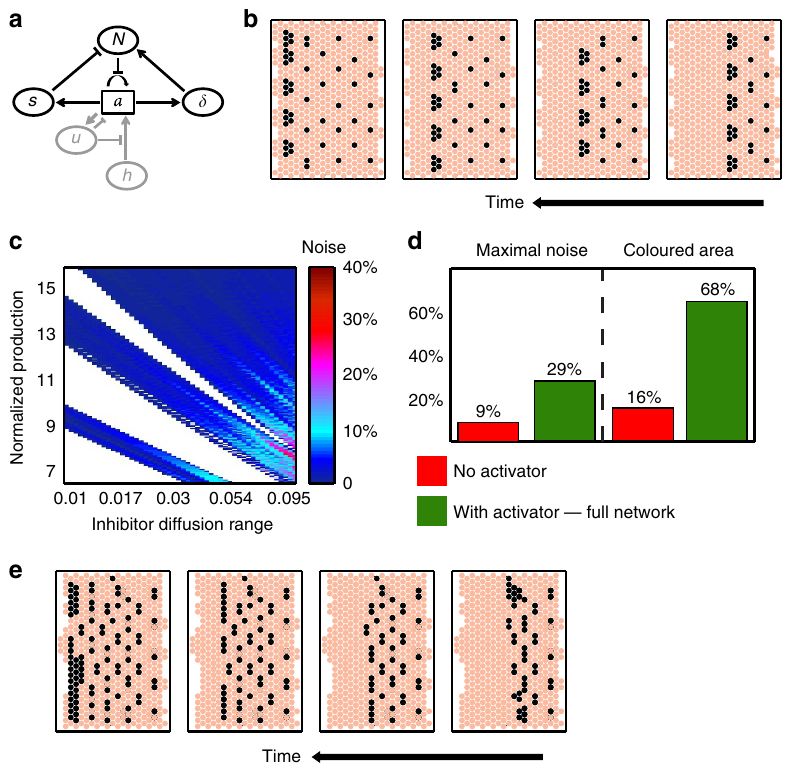
Figure 4 | Simulating sca function as a competitive inhibitor of Notch activity. ( a ) Model scheme of the full network including Notch and Delta. Model equations are given in the Methods and in Supplementary Note 7. ( b ) Introducing the Notch–Delta interactions enables simulating cluster formation together with cluster refinement. Simulations of the same eye disc are shown at different times (indicated by horizontal arrow), capturing the different stages in eye development. ( c , d ) An analysis of the sensitivity of the model to spatial heterogeneity for the extended model. Quantitative comparison of the robustness with or without the addition of the short-range activator is shown in d . Left panel compares the maximal noise that could be added in simulations of the full network shown in c to that in simulations in Fig. 1e (no activator). Right panel compares the area of the coloured regions in these simulations, where patterns could be obtained. Parameters can be found in Supplementary Table 3. ( e ) In sca loss of function mutants, the first distinct phenotype is impaired cluster formation because of increased sensitivity to spatial heterogeneity. The second distinct phenotype is reflected in many cases of impaired cluster refinement leading to a high frequency of twining. Simulations are shown at different times, similar to those shown in b